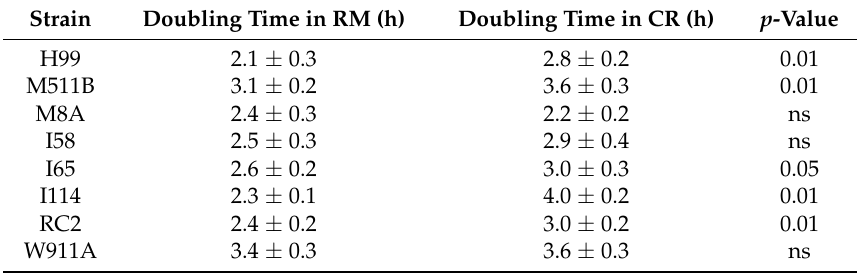
Table 1. Doubling times of C. neoformans strains in rich media (RM) and calorie-restricted media